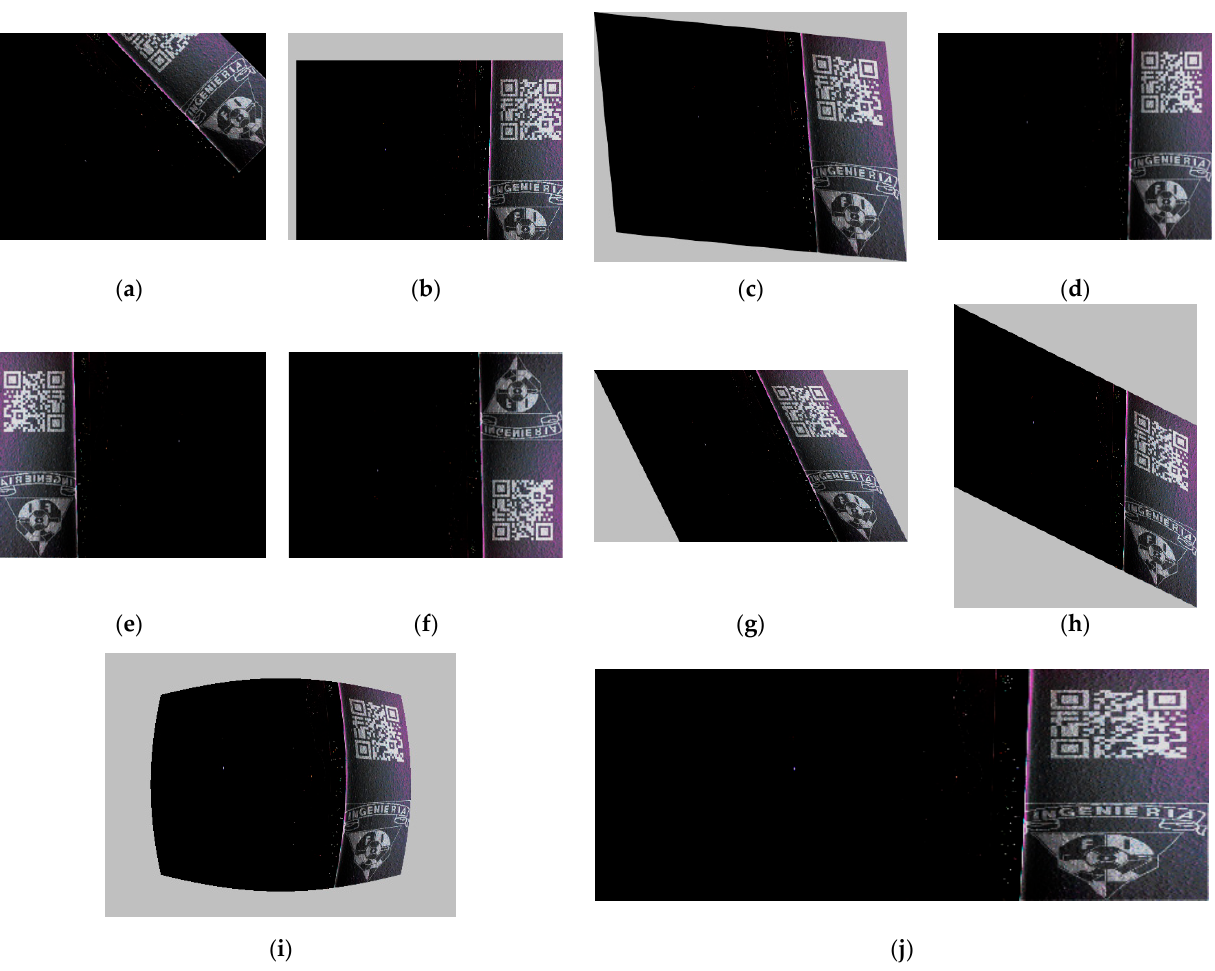
Figure 15. Robustness against common geometric attacks, ( a ) rotation, ( b ) translation with cropping, ( c ) affine transformation, ( d ) rescaling, ( e ) flip—horizontal transformation, ( f ) flip—vertical transformation, ( g ) shearing—x-direction, ( h ) shearing—y-direction, ( i ) barrel transformation, ( j ) aspect ratio.